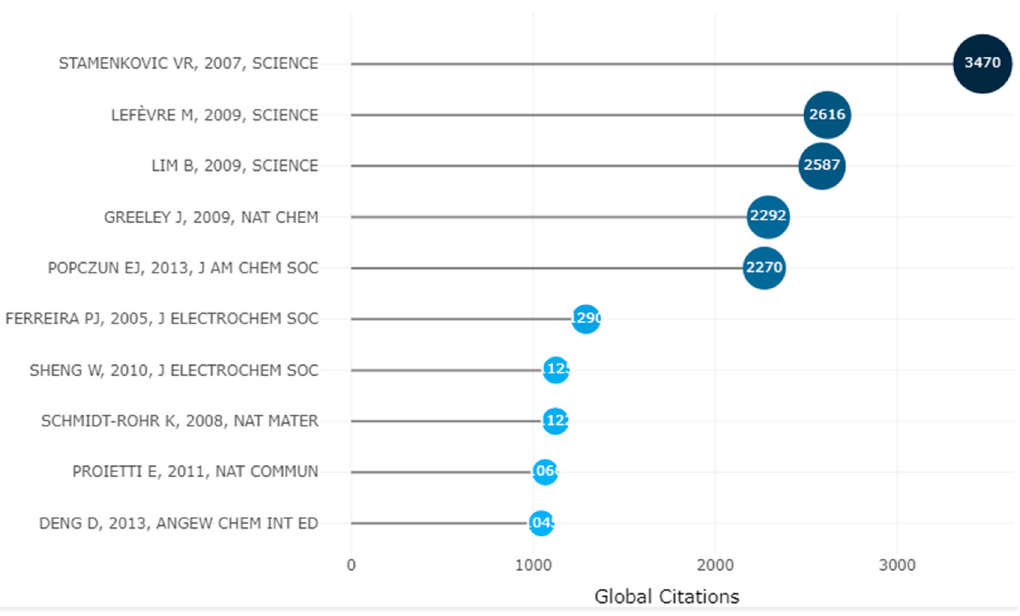
Figure 18. Top 10 most cited PEMFC articles.